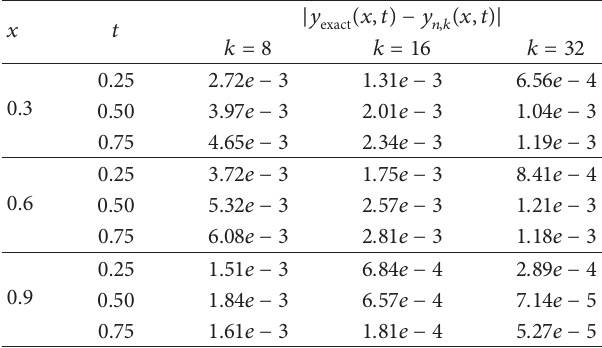
Table 1: The values of absolute error with 𝑛 = 3 for Example